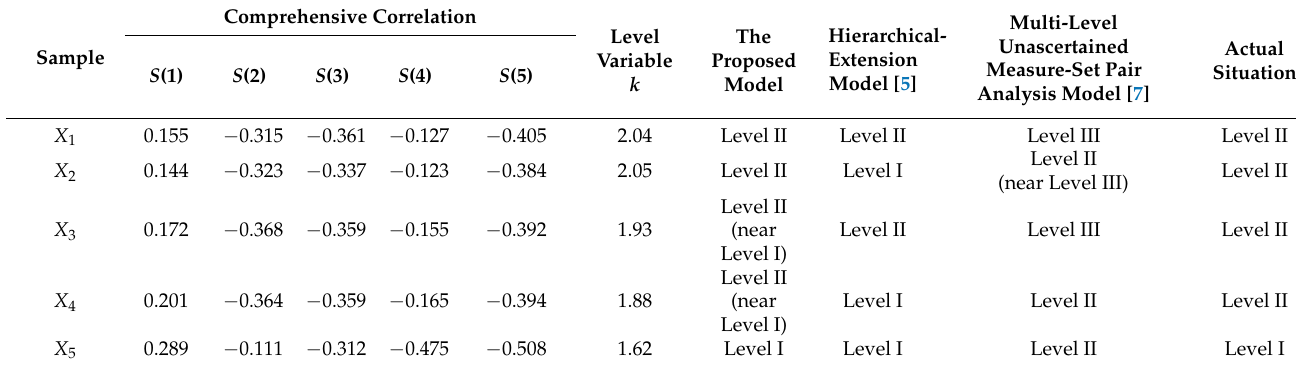
Table 7. Evaluation results of the slope rock mass